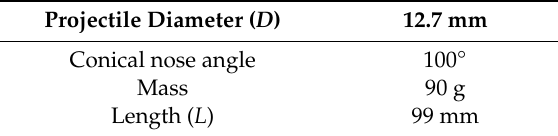
Figure 5. Computational model of water-entry projectile. Table 1. Parameters of the